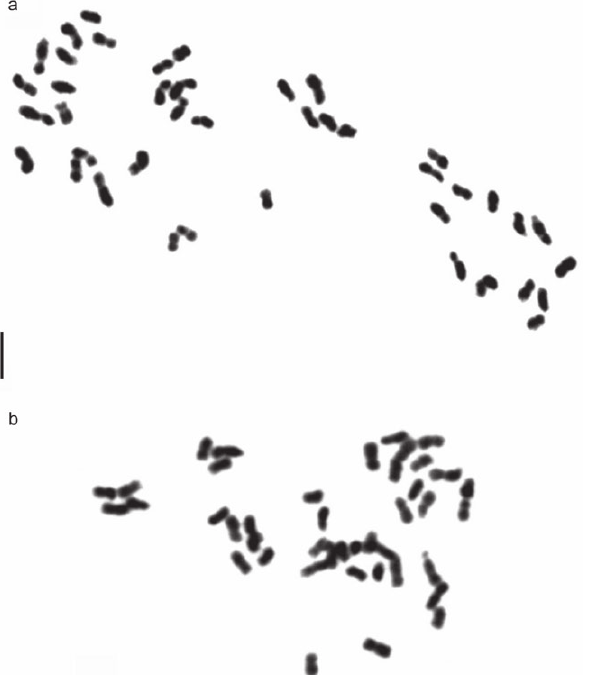
Figure 1. Mitotic metaphase with Feulgen staining of Platanthera chlorantha (a) and P. algeriensis (b); 2n = 2x = 42. Bar = 5 µm.